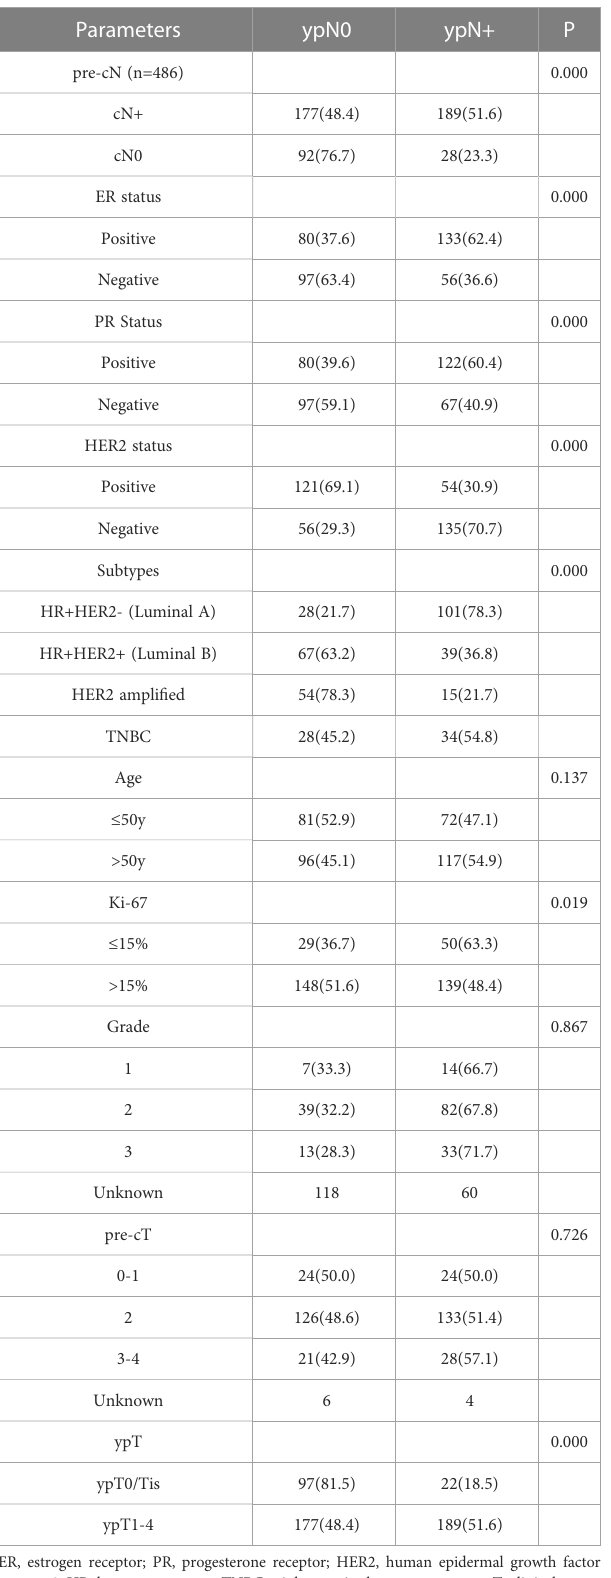
TABLE 2 The correlation between ypN stages after NAT and clinicopathological characteristics in pre-cN+ patients (n=366).